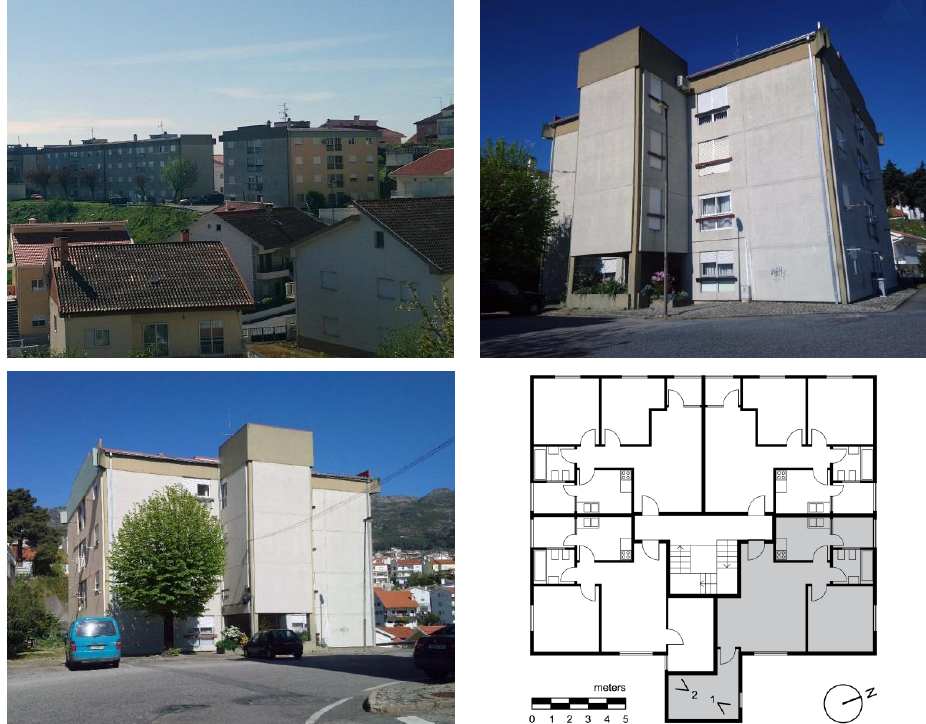
Figure 3. The CAR (Comissão para o Alojamento de Refugiados) studied project: photos and typical floor plan of the building located in Covilhã.